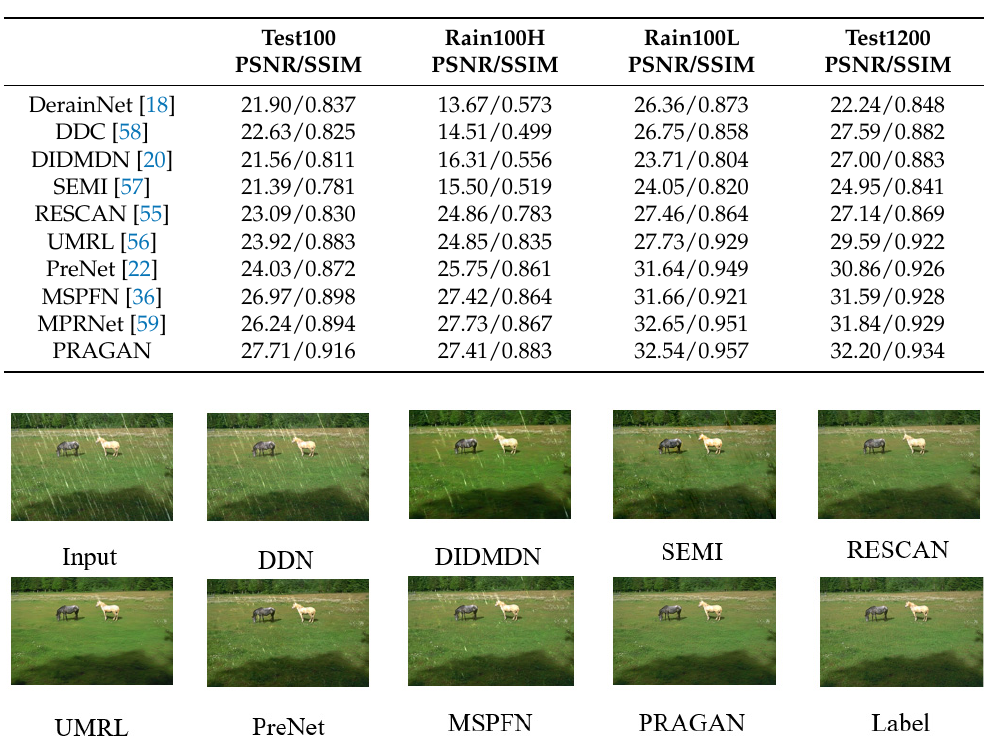
Table 6. Comparative results on synthetic deraining datasets, all models were directly tested on Test1200 [20]. For MPRNet [59], we retrained it with the same number of iterations using the same experimental configuration as our proposed method. Specifically, MPRNet [59] was trained for 63 epochs with all training data.